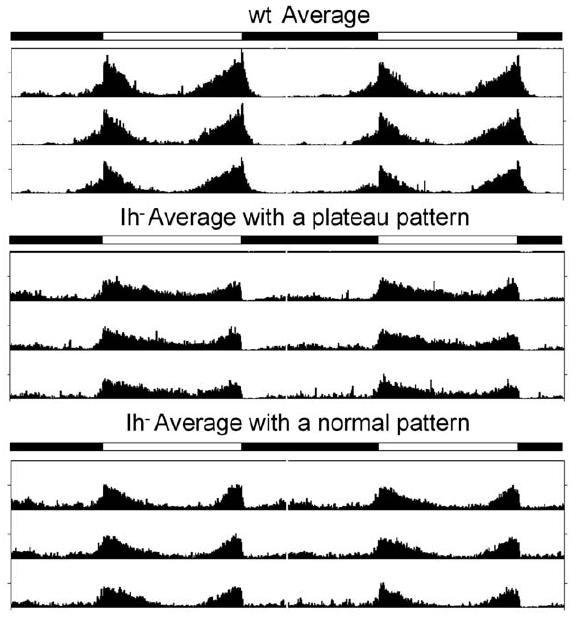
Figure 5. DmIh mutant flies lose the characteristic bimodal activity pattern in LD. Average actograms show the typical bimodal pattern of activity in LD in most of the control flies (98.4%, n=53; top) and in 58.9% of the DmIh mutant flies (average of 33 flies; bottom ‘‘Ih 2 Average with a normal pattern’’). However, the rest of the DmIh mutant flies (41.1%, n=23) display an altered pattern characterized by a plateau of sustained activity during the light period (middle ‘‘Ih 2 Average with a plateau pattern’’). Mutant flies also show a (plateau of?) sustained activity during the night.